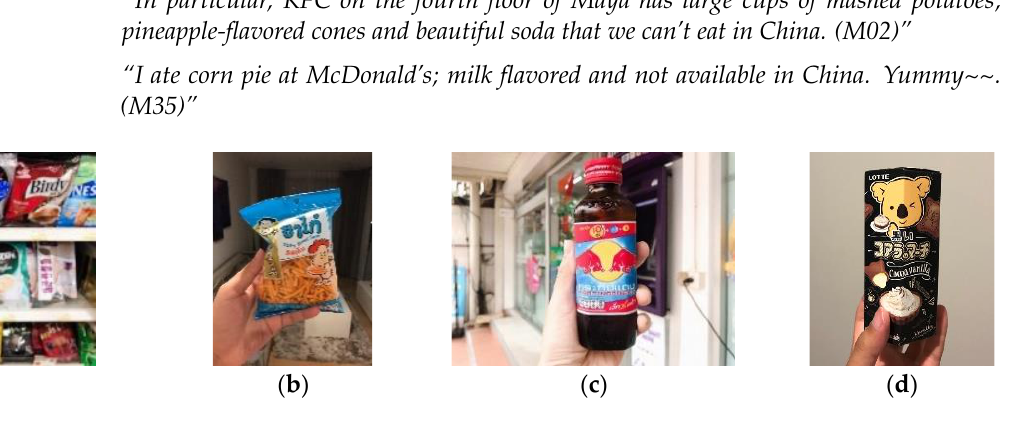
Figure 4. Images of glocalized foodscape: some snacks with global brands, ( a ) Oreo ice-cream; ( b ) puffing food; ( c ) the Redbull drinks; ( d ) sandwich biscuit.